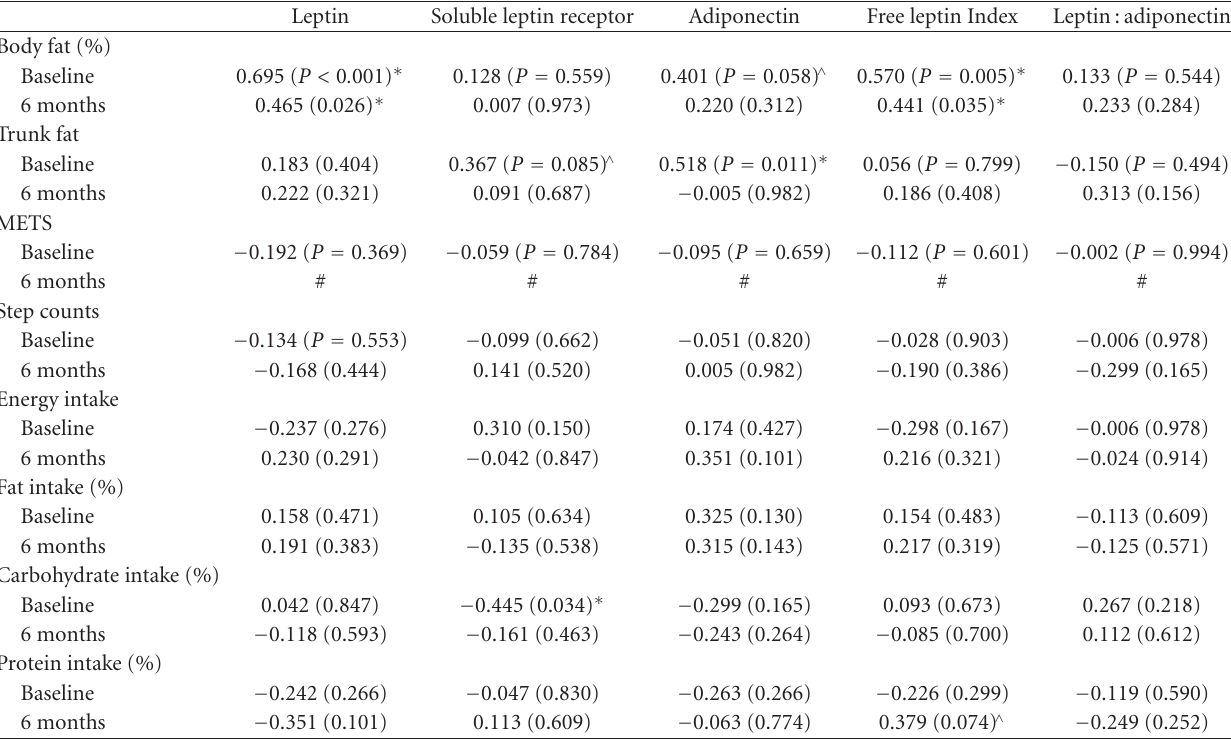
Table 4: Spearman correlations at baseline and 6 months for men between adipokines and body fat %, trunk fat, step counts, dietary intake, and peak METS from GXT (baseline only). Data are presented as rho correlation coe ffi cient ( P